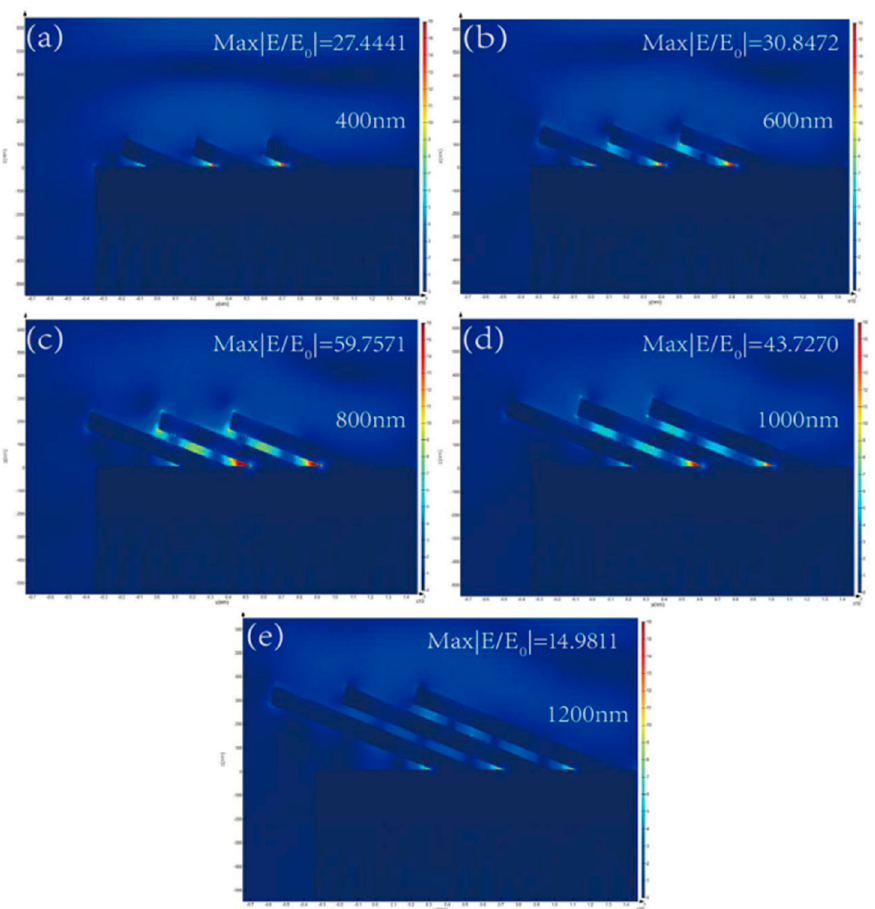
Figure 4. Calculation results of the AuNRs array with different lengths by the FDTD method: ( a ) L =